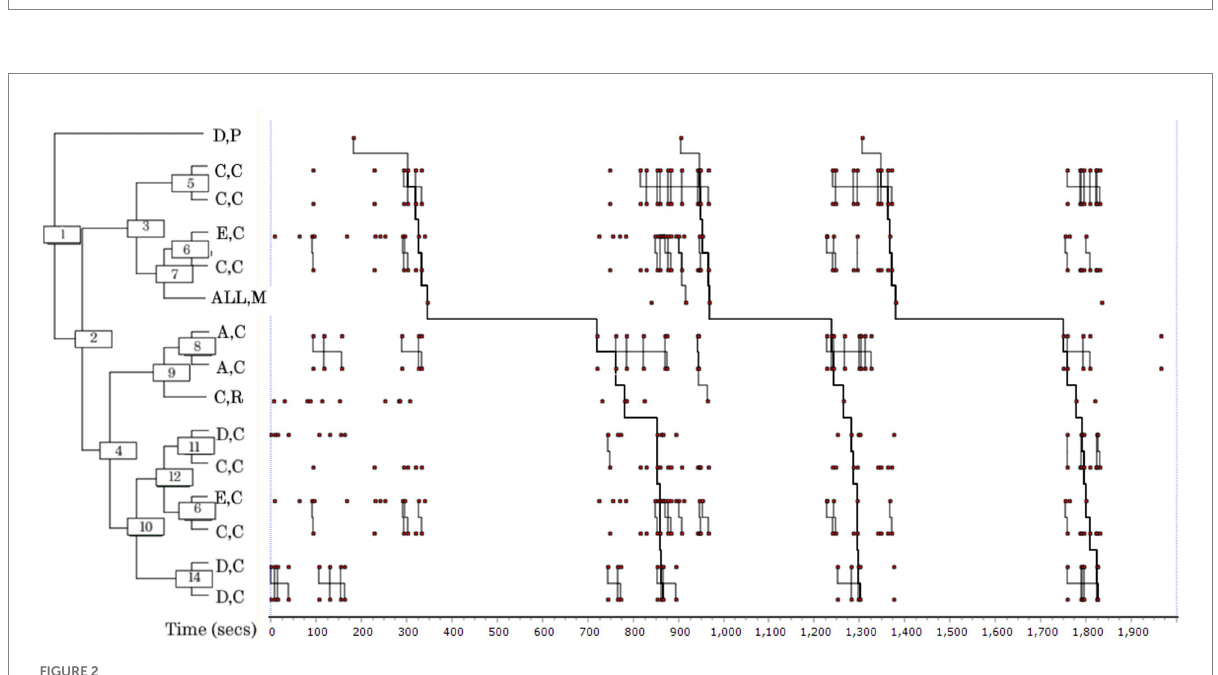
FIGURE 2 Pattern diagram (dendrogram) output from THEME ® analysis showing main patterns and frequent sub patterns (Group 1, Week 5). In this week, patterns precede and follow group singing episodes (All, M). Features include longer patterns and numerous dyadic and mono-actor sub patterns. A light-hearted or humorous contribution from Singer D is followed by mono-actor Clarifying interactions (2, 8, 14) and dyadic exchanges between E and C, and D and C (6, 11). Patterns following singing (4) involved each of the singers engaged in Clarifying, apart from one sub pattern including Reacting